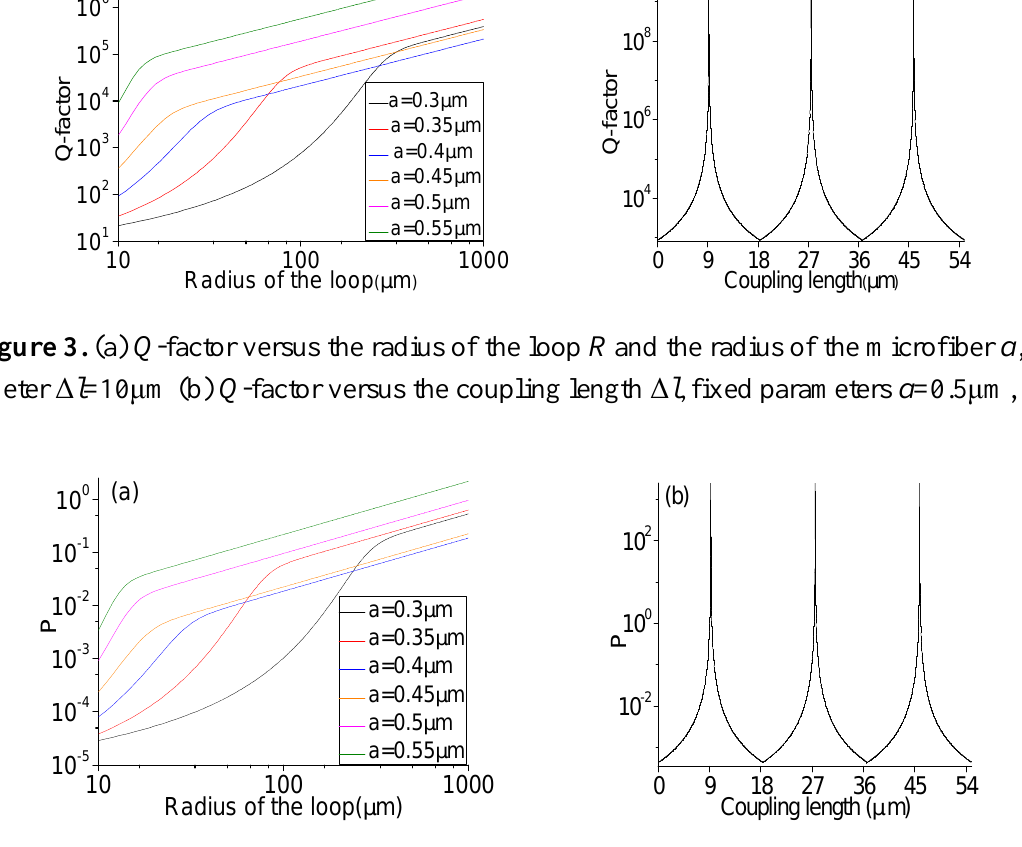
Figure 4. (a) The detection limit factor P versus the radius of the loop R, fixed parameter ∆ l =10 µ m. (b) The detection limit P versus the coupling length ∆ l , fixed parameters a =0.5 µ m, R =55 µ